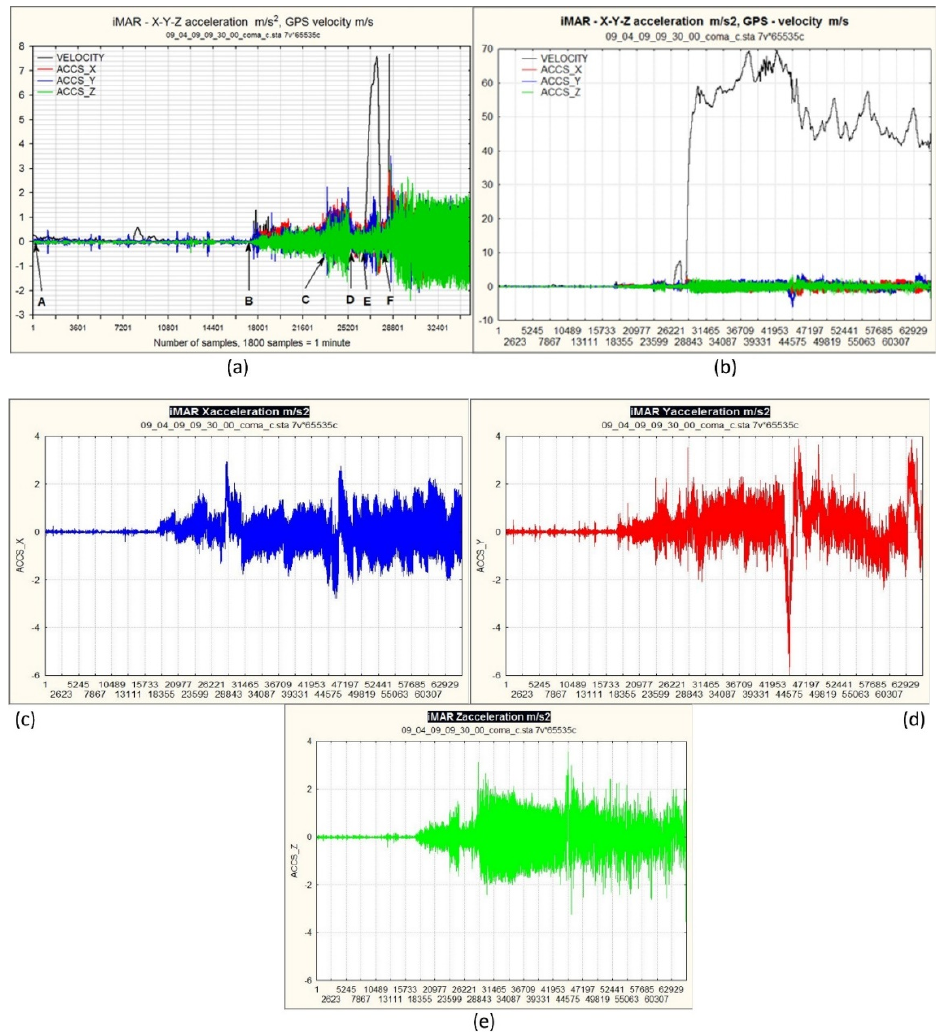
Figure 10. ( a ) Vibration phases: AB engines off, BCD engines on, EF increase power and take off, > F flight; ( b ) the diagram shows the speed (velocity, m/s) and acceleration dependence on the X , Y and Z axes (ACCS_X, ACCS_Y, ACCS_Z, m/s²) in relation to the number of samples. Speed was calculated based on data from the GPS receiver with a frequency of 1 Hz, and acceleration was read from iMAR with a frequency of 20 Hz on the measured platform accelerations per axis: ( c ) X axis, ( d ) Y axis and ( e ) Z axis.